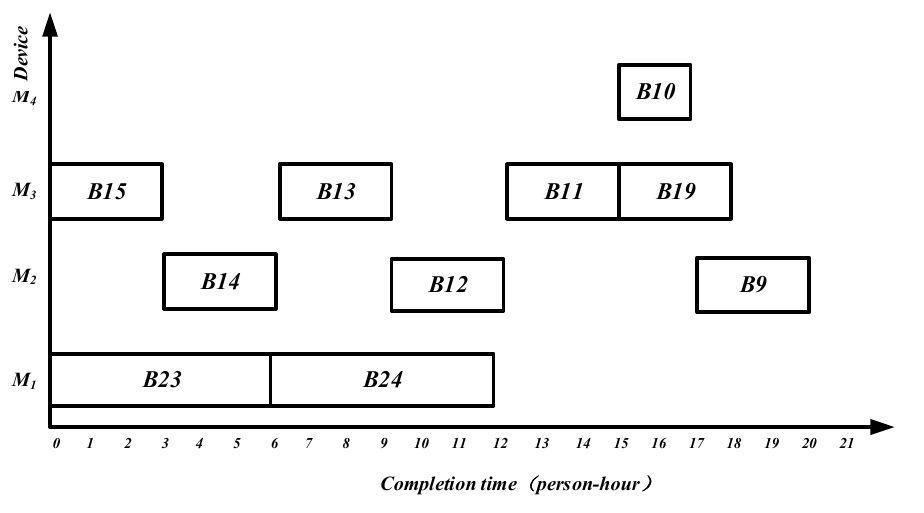
Figure 15. Gantt chart of workshop f 1 with 20 person-hours.